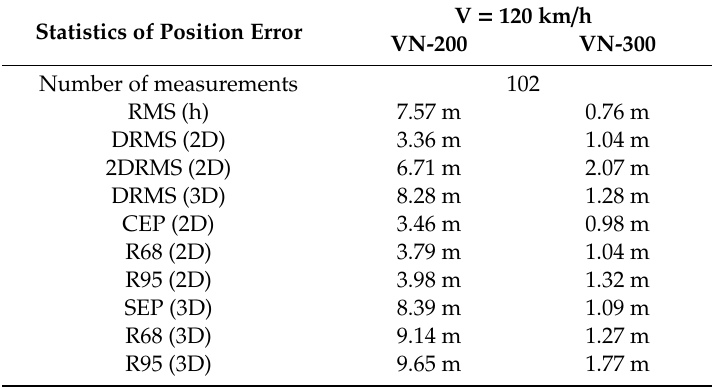
Table 10. Predictable positioning accuracy of VN-200 and VN-300 systems during Inertial Navigation System (INS) measurements in Gda´nsk in section no.